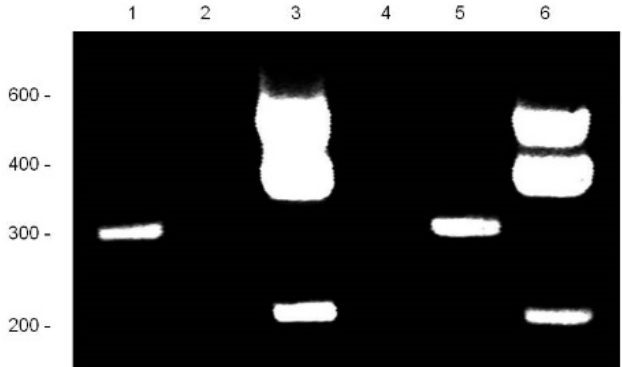
Figure 2. RACE Analysis of TOSPEAK : RACE analysis of mRNA was used to identify the boundaries of the TOSPEAK gene. 5 ′ RACE (Lanes 1 & 5) and 3 ′ RACE (Lanes 3 & 6) identified the start site and termination sequence of TOSPEAK , respectively. RACE products were PCR amplified using Elongase enzyme (Lanes 1 & 3) and Titanium enzyme (Lanes 5 & 6) using TOSPEAK- 2 forward and reverse primer sets, respectively (Table 1).